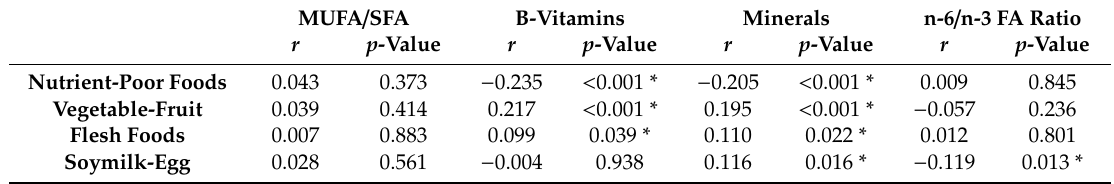
Table 3. Correlation between the four nutritional biochemistry factors and the four dietary factors. MUFA /